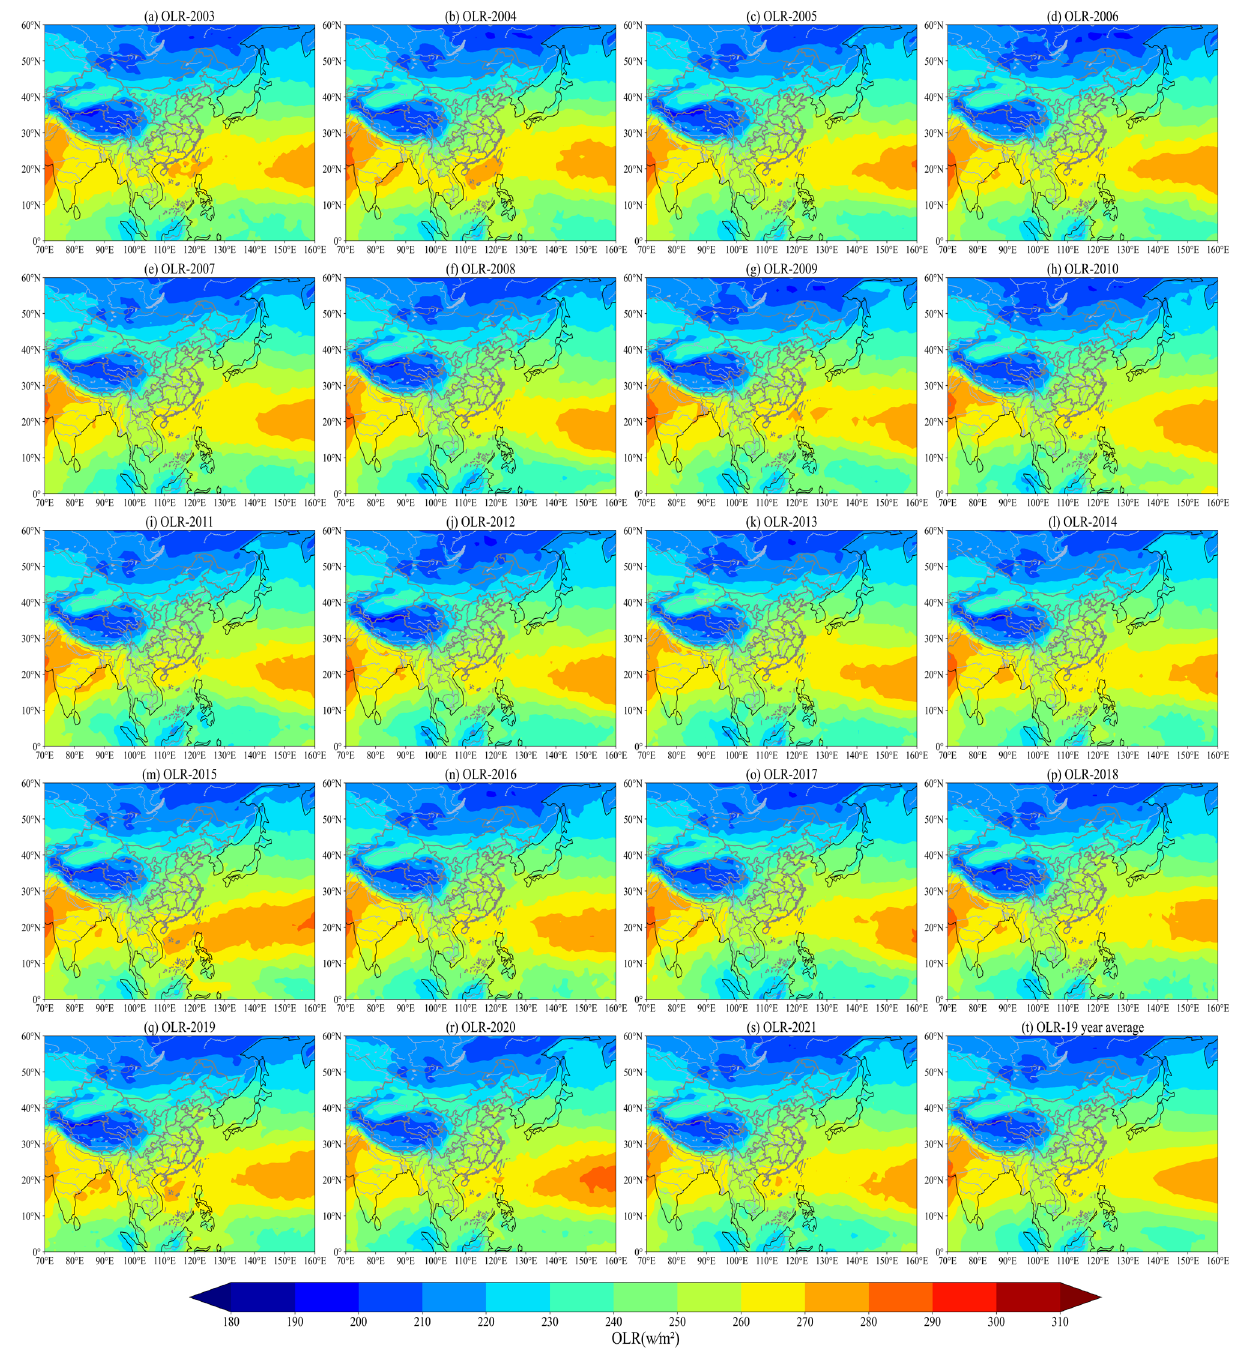
Figure 1. Year-by-year spatial distribution of OLR in East Asia in the past 19 years and the 19 year average.